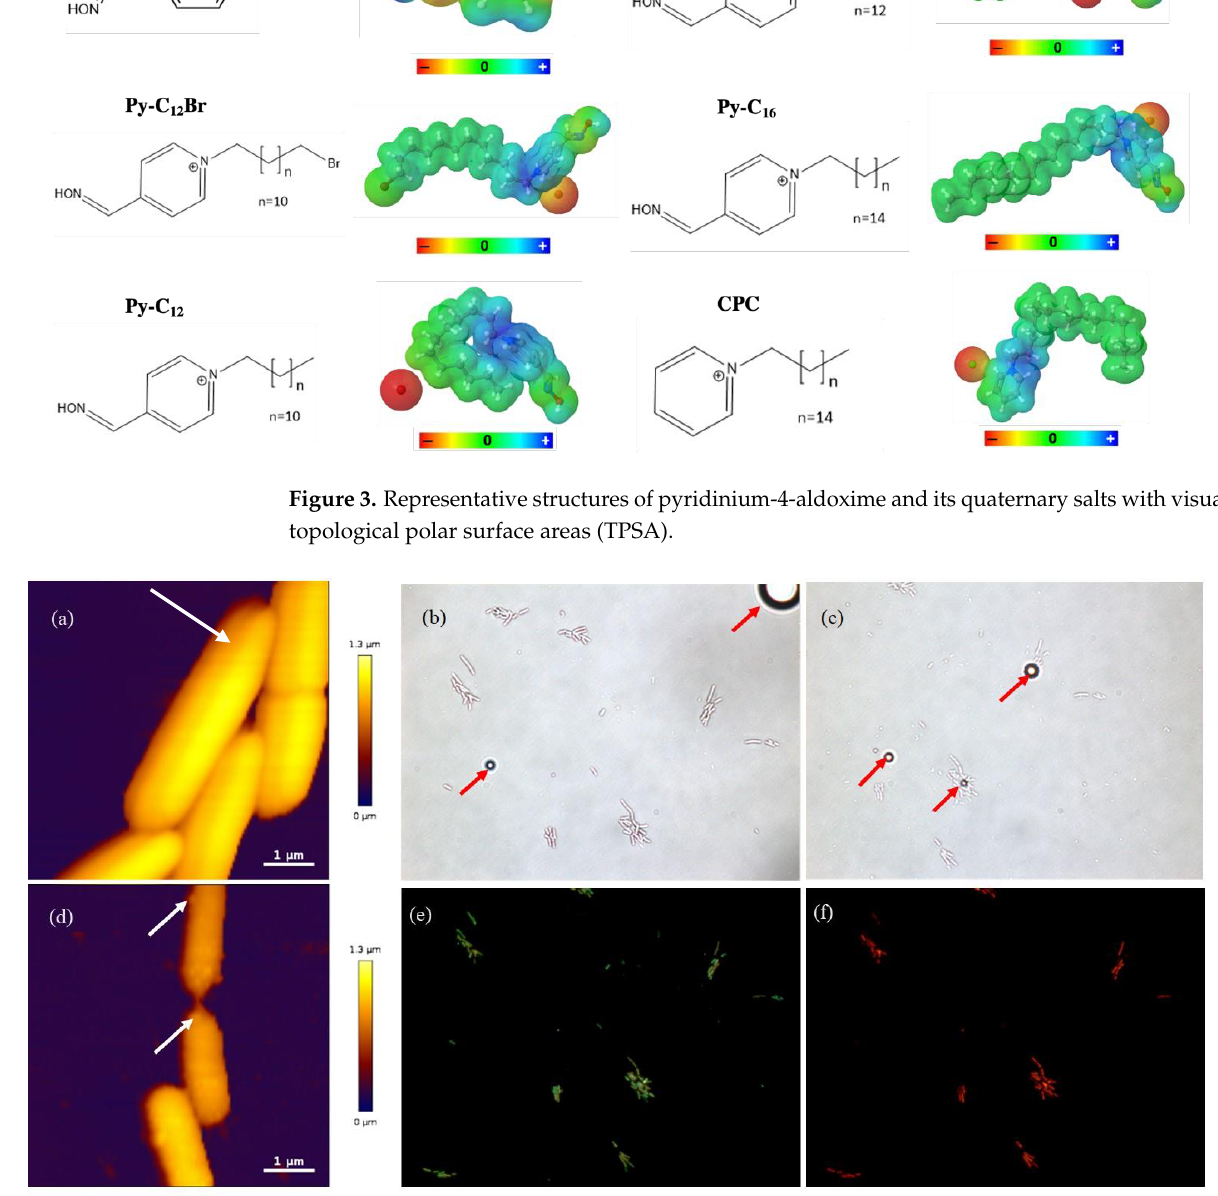
Figure 4. Atomic force and optical microscopy data of untreated and treated bacterial cells: ( a ) Height AFM image of untreated Escherichia coli DH5 α cells, ( b ) bright-field image of cell groups taken at the very beginning of treatment — the arrows indicate possible vesicles, ( c ) bright-field image of the exact same sample area as in ( b ) taken after 3 hours of cell treatment and vigorous rinsing with the Muller-Hinton broth — the arrows indicate possible vesicles, ( d ) height AFM image of bacterial cells — the arrows indicate possible micelles attached at the cell surface or membrane blebbing, ( e ) SYTO 9 fluorescence image of the exact same sample area as in ( b ) and ( c ), acquired after 3 hours of treatment, ( f ) Propidium iodide fluorescence image of the exact same area as in ( e ), acquired after 3 hours of treatment.